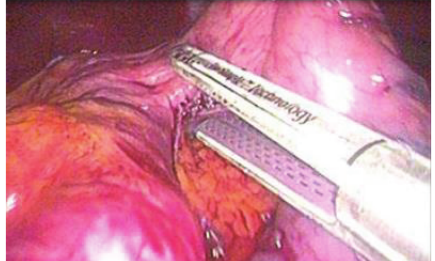
Figure 3: Placing stapler’s blunt and thick side facing